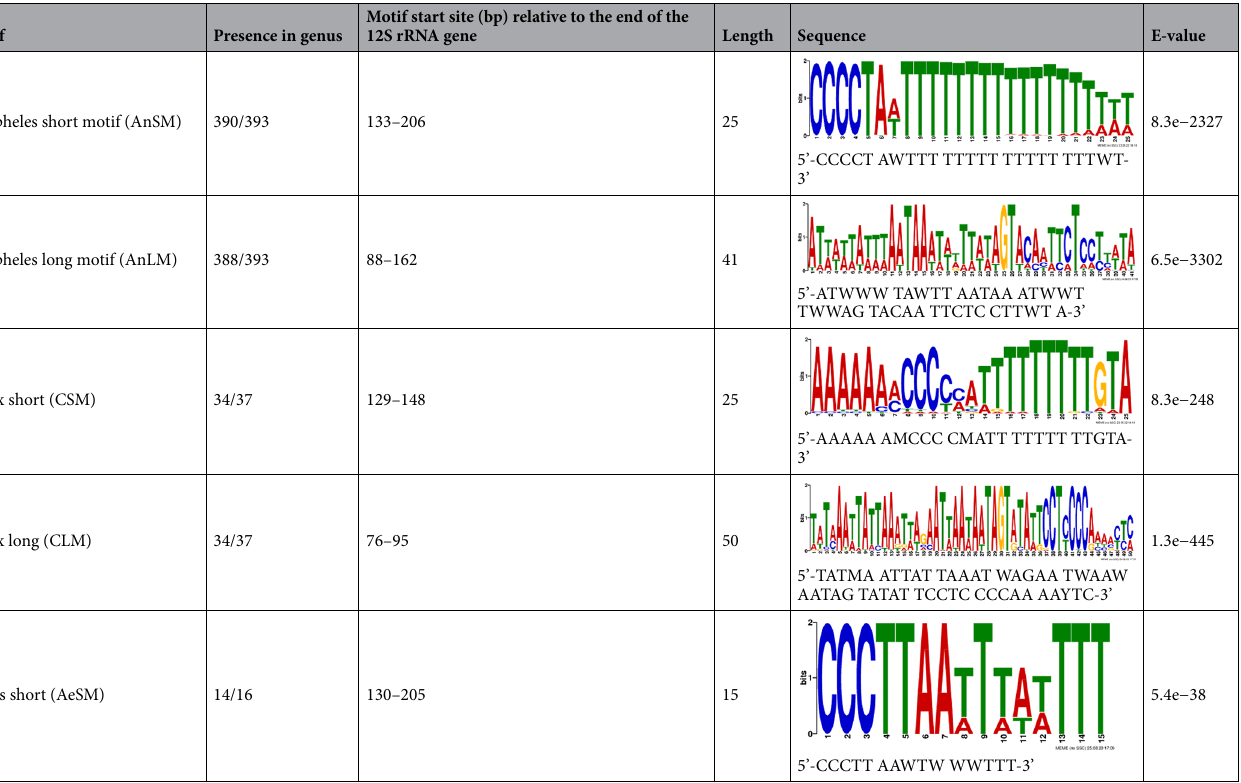
Table 3. Conserved motifs found in mosquito mitogenomes control regions.